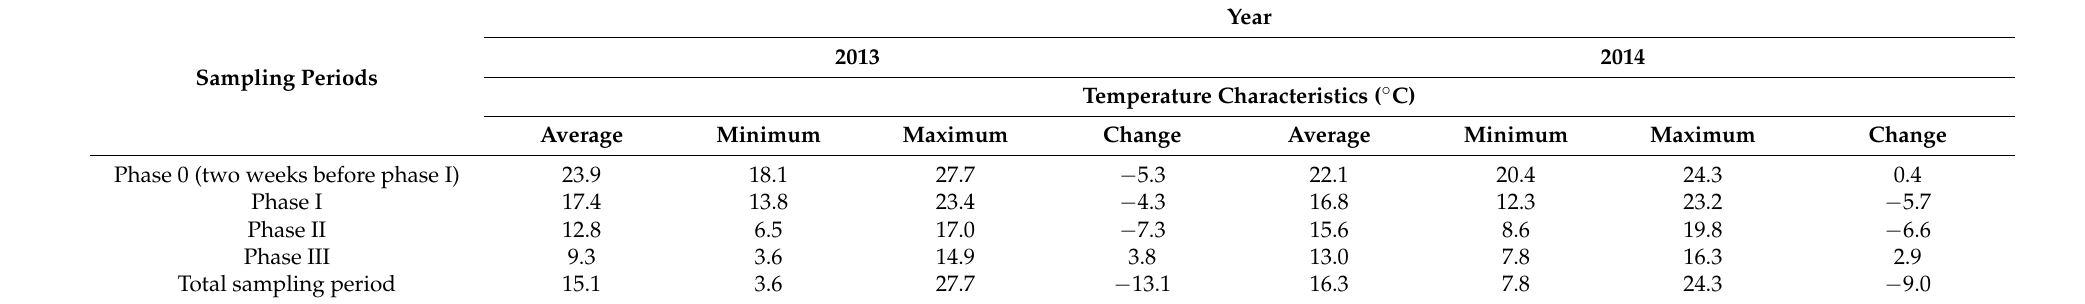
Table 2. Temperature profile characteristics in the sampling periods in 2013 and